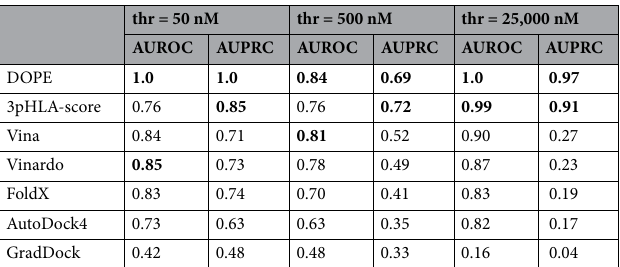
Table 3. Quantified power of scoring functions to discriminate between peptides of different binding strength on the Dataset 3. ∗ Top 2 performing values are bolded. ∗∗ thr: threshold of binding affinity used to label different